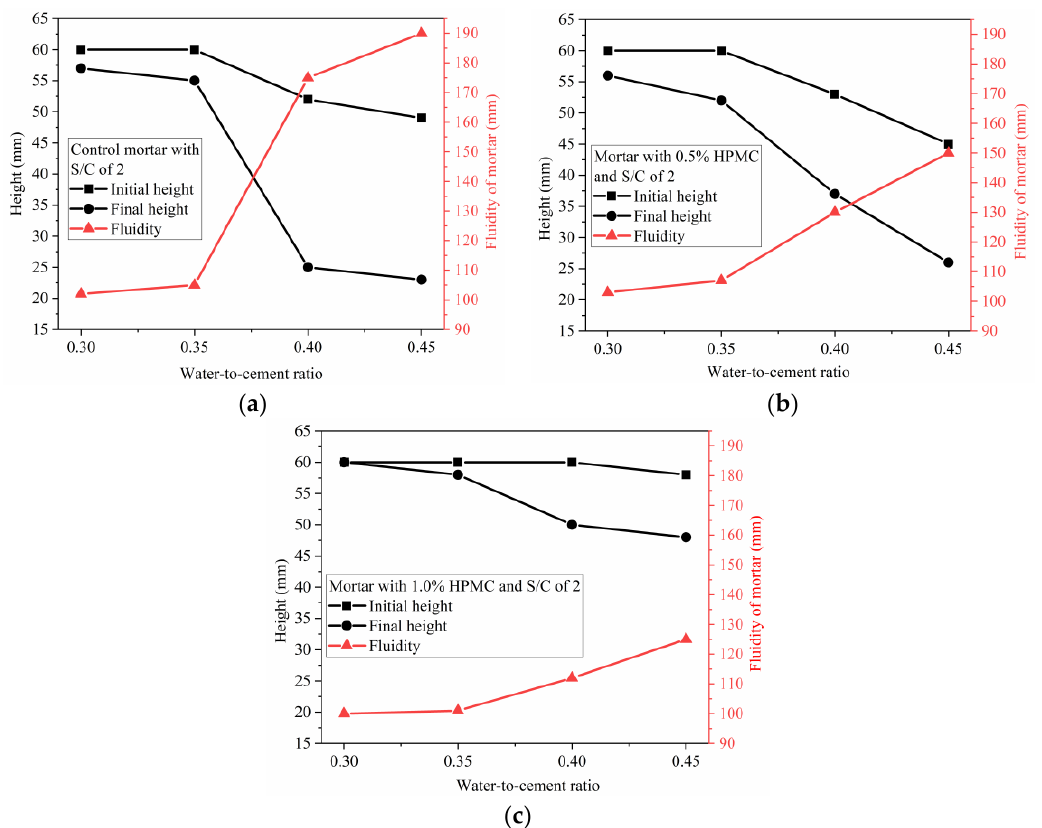
Figure 9. Initial height, final height and fluidity of SAC mortar Vs. W/C ratio with maintaining S/C ratio of 2: ( a ) control mortar; ( b ) mortar blended with 0.5% HPMC; ( c ) mortar blended with 1.0% HPMC.